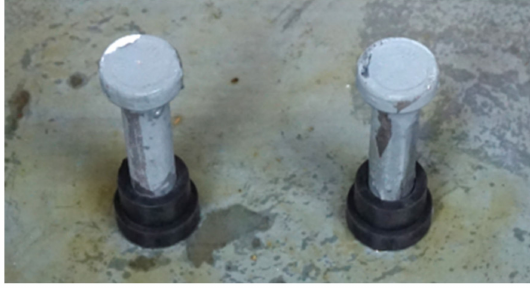
Figure 3. Rubber-sleeved